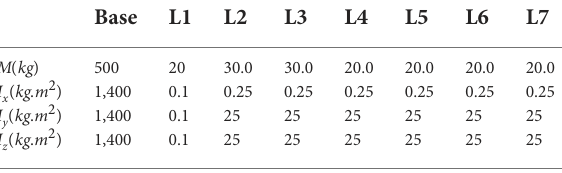
TABLE 2 The inertial properties of the space